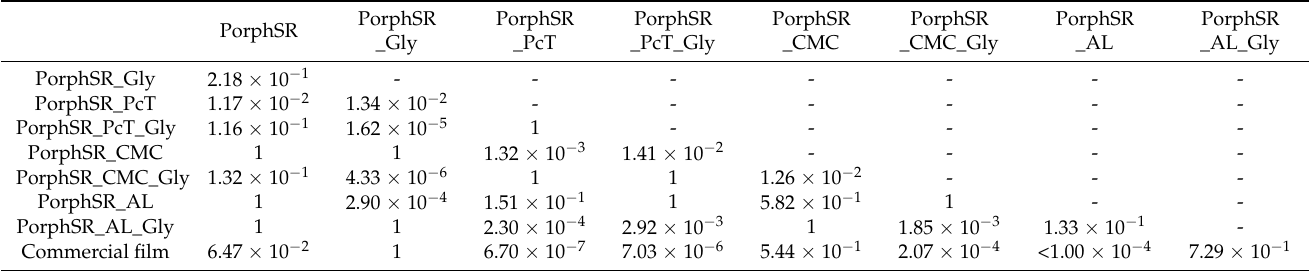
Table A6. Bonferroni pairwise comparison p -values for the different films’ ultimate tensile strengths.